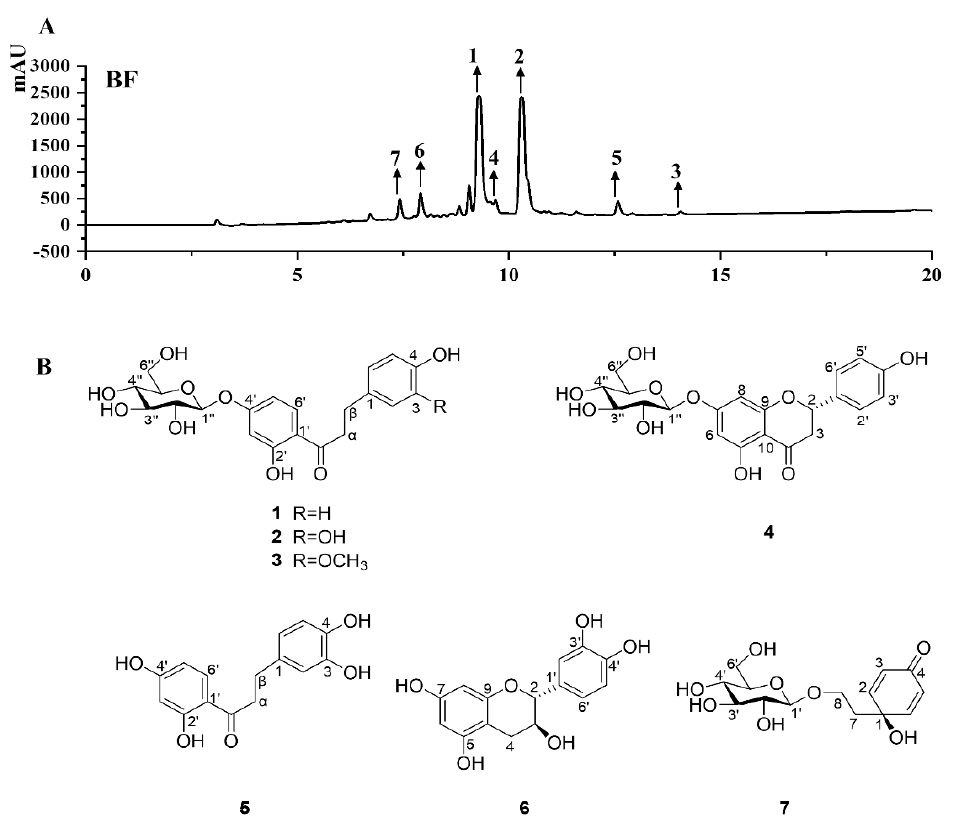
Figure 1. ( A ). HPLC chromatogram of BF from Anneslea fragrans. ( B ). Chemical structures of the compounds 1 ‒ 7 . compounds 1 – 7